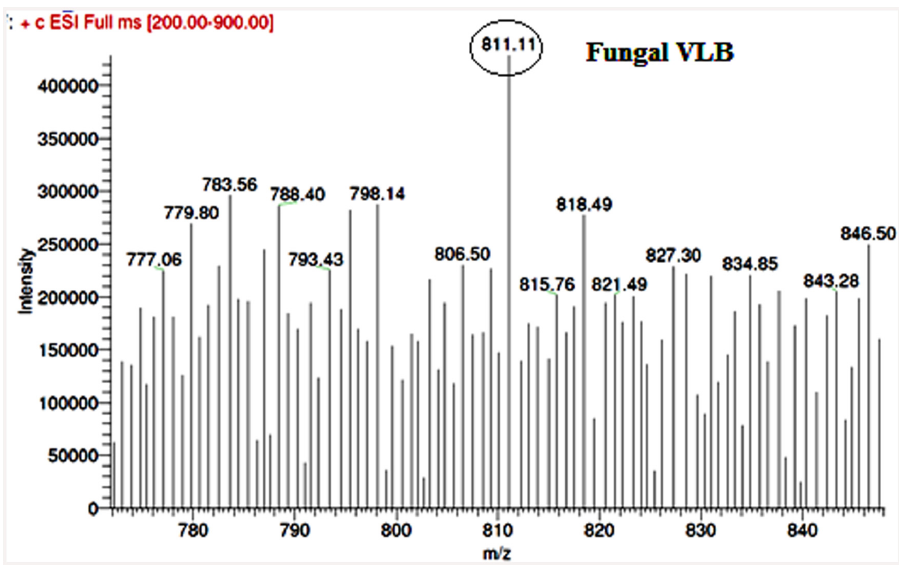
Fig 10. LC-ESI-MS analysis of fungal VBL. The mass spectrum of the fungal extract showed a (M+H + ) peak at a molecular mass of 811.51, which was identical to that observed in the mass spectrum of the VBL